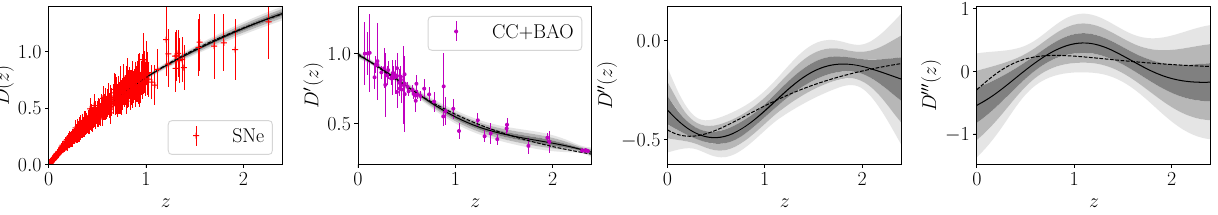
The shaded regions correspond to the 68, 95 and 99 . 7% con-